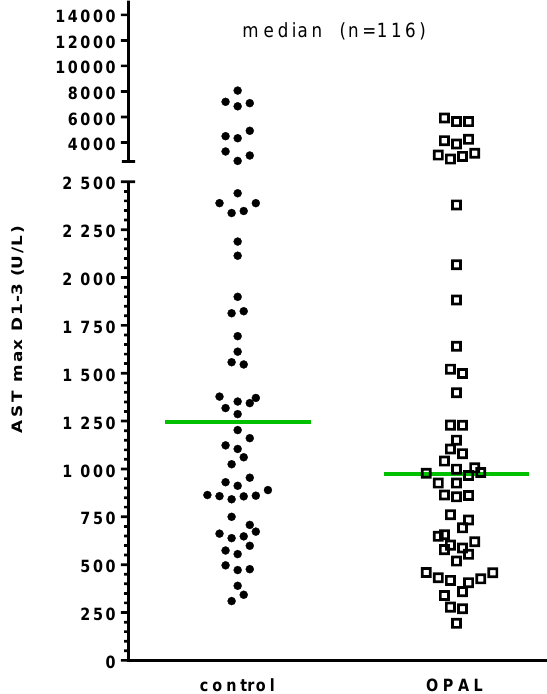
Figure 2. Peak values of AST during the first 3 days after transplantation.